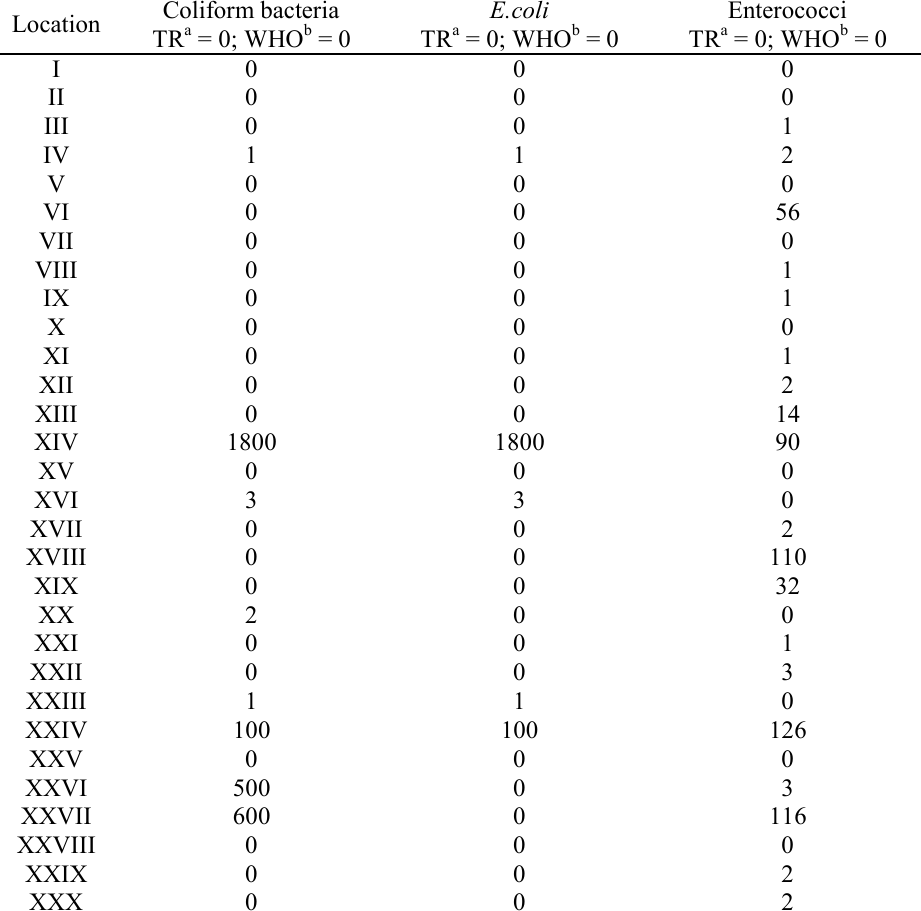
Table 3. Microbiological values of the drinking water samples from Cankiri, Turkey (cfu/100